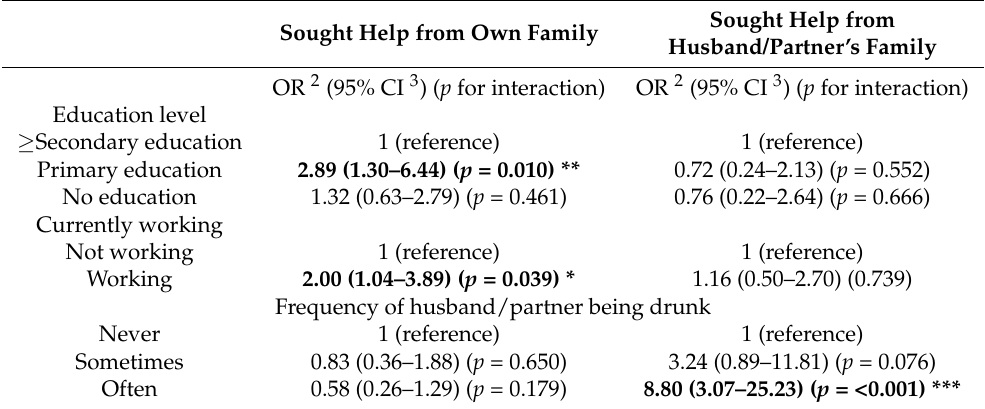
Table 4. The modifying effects of seeking help from family for IPV 1 exposure on Haitian women. Sought Help from Own